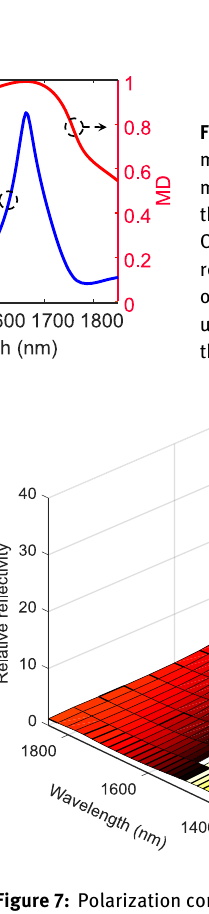
Figure 7: Polarization conversion using the active metasurface in Figure 1. The reflection amplitude ratio ( | r x | ∕ | r y | ) and the relative phase ( 𝜙 x − 𝜙 y ) between the two orthogonally polarized components of the reflected light as a function of the GST ) ( L % and the wavelength. Different polarization crystallization level c states can be realized in the output by moving on the surface of the plot (i.e., through changing the GST phases).